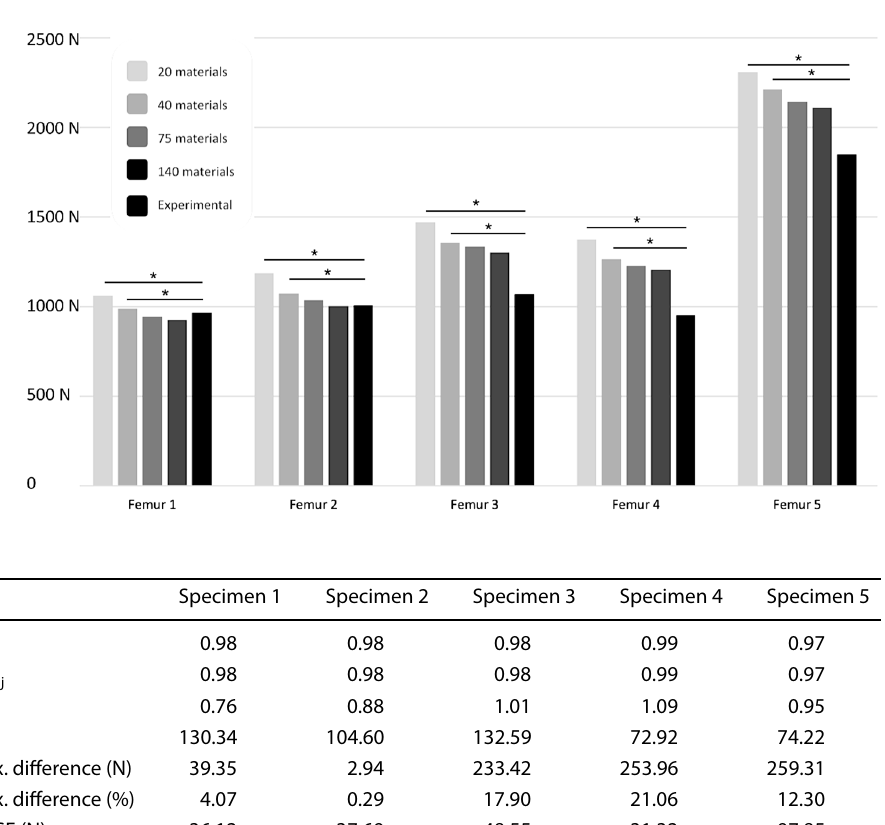
R 2 coefficient of determination; R 2